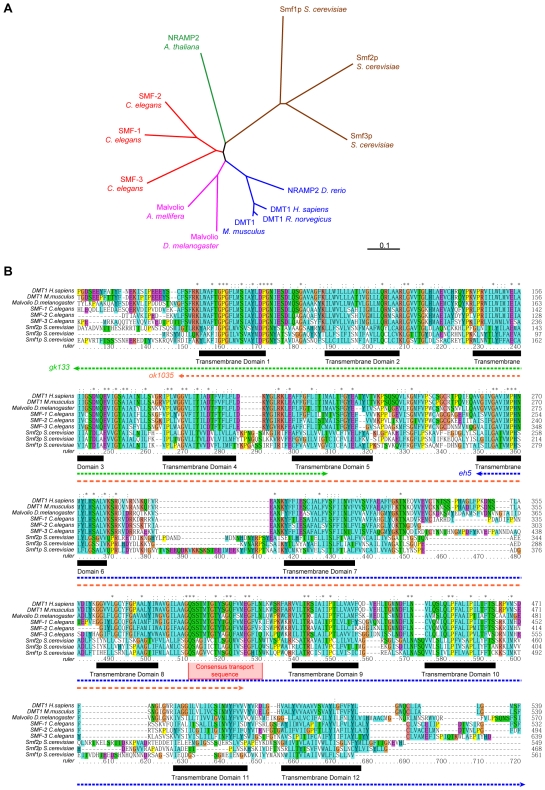
The C. elegans genome encodes 3 SMF transporters orthologous to the plant, fungi and animal DMT protein family.(A) Unrooted phylogenetic tree of a subset of eukaryotic members of the DMT family of transporters. C. elegans SMF proteins are more closely related to the animal than to the fungus or plant orthologues. (B) Multiple alignment of animal DMT1 orthologues. The 12-transmembrane domain topology of vertebrate DMT1 is conserved in C. elegans SMF proteins (black boxes), as well as the consensus transport sequence (red box). Dotted arrows indicate regions of the proteins affected by the deletion alleles eh5, gk113, and ok1035 of smf-1, 2, and 3 respectively. Amino acids with similar biochemical properties are highlighted with the same color. * represent residues conserved in all aligned sequences, : corresponds to highly conserved residues and. to less conserved residues.